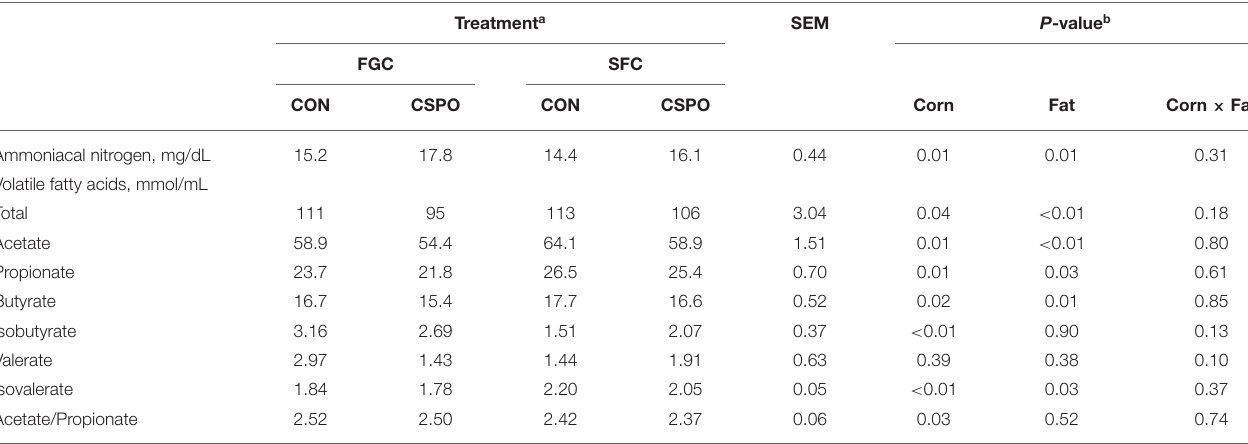
TABLE 6 | Rumen fermentation parameters of dairy cows receiving the treatment diets (Experiment 2). Treatment a SEM P -value b